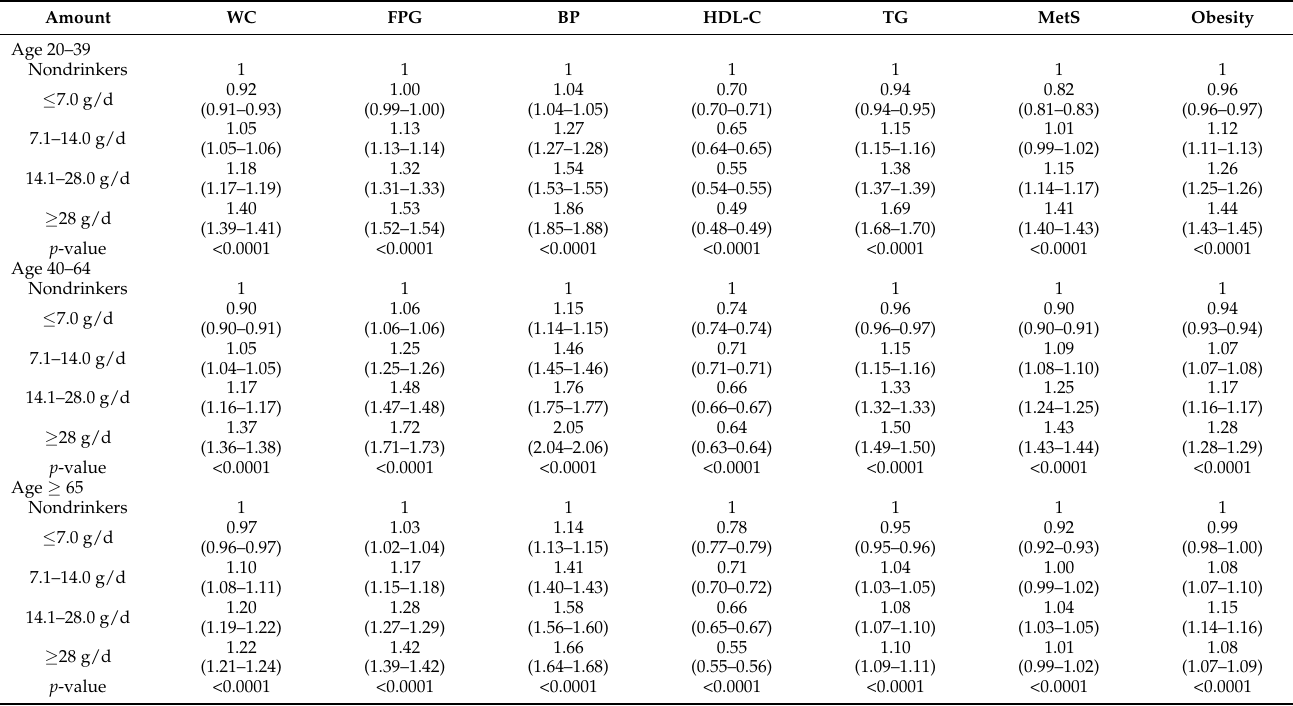
Table 4. Odds ratios of metabolic syndrome and obesity according to age in